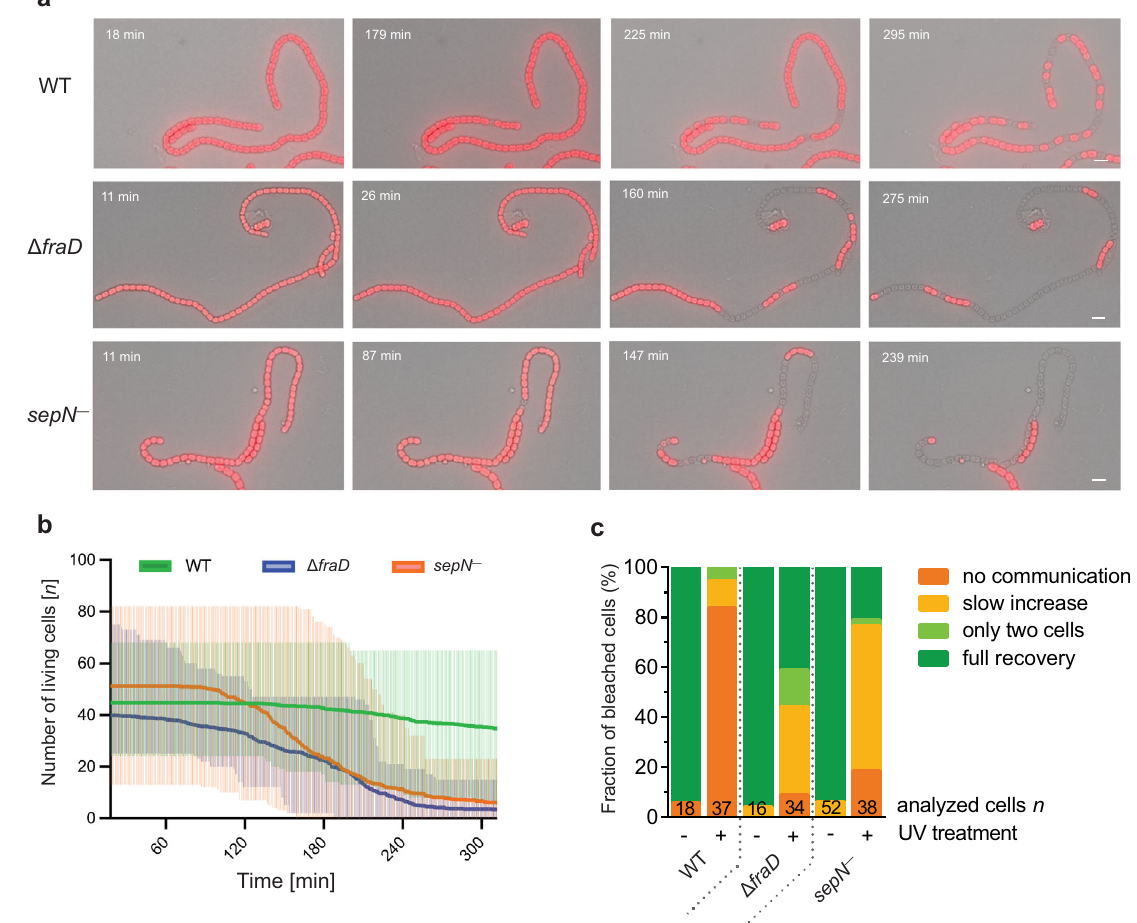
Fig.7|Controlledcell – cellcommunicationiscrucialfor fi lamentsurvivalafter stress. a Merged bright fi eld and fLM time-lapse of stressed Nostoc WT, Δ fraD , and sepN − mutants after 5min UV exposure. Living cells show red auto fl uorescence originating from photosynthetic pigments. With increasing time, cells within the fi laments start to lyse, which results in fi lament fragmentation. While in the WT mainly individual cells lyse, lysis in the mutant strains occurs faster and cells often lyseinclustersofseveralcontiguouscells.Thetimepost-UVtreatmentisindicated in images. For full-length time-lapse, see Supplementary Movies 1 – 3. The experi- ment was repeated independently three times with similar results and in total 54 time-lapse movies were acquired. Bars, 10 µ m. b Quanti fi cation of cell lysis in the twelve fastest lysing fi laments from 5h fLM time-lapse movies. In the Δ fraD and sepN − mutants, lysisevents increase after about 2h post UV exposure. After 5h, 93